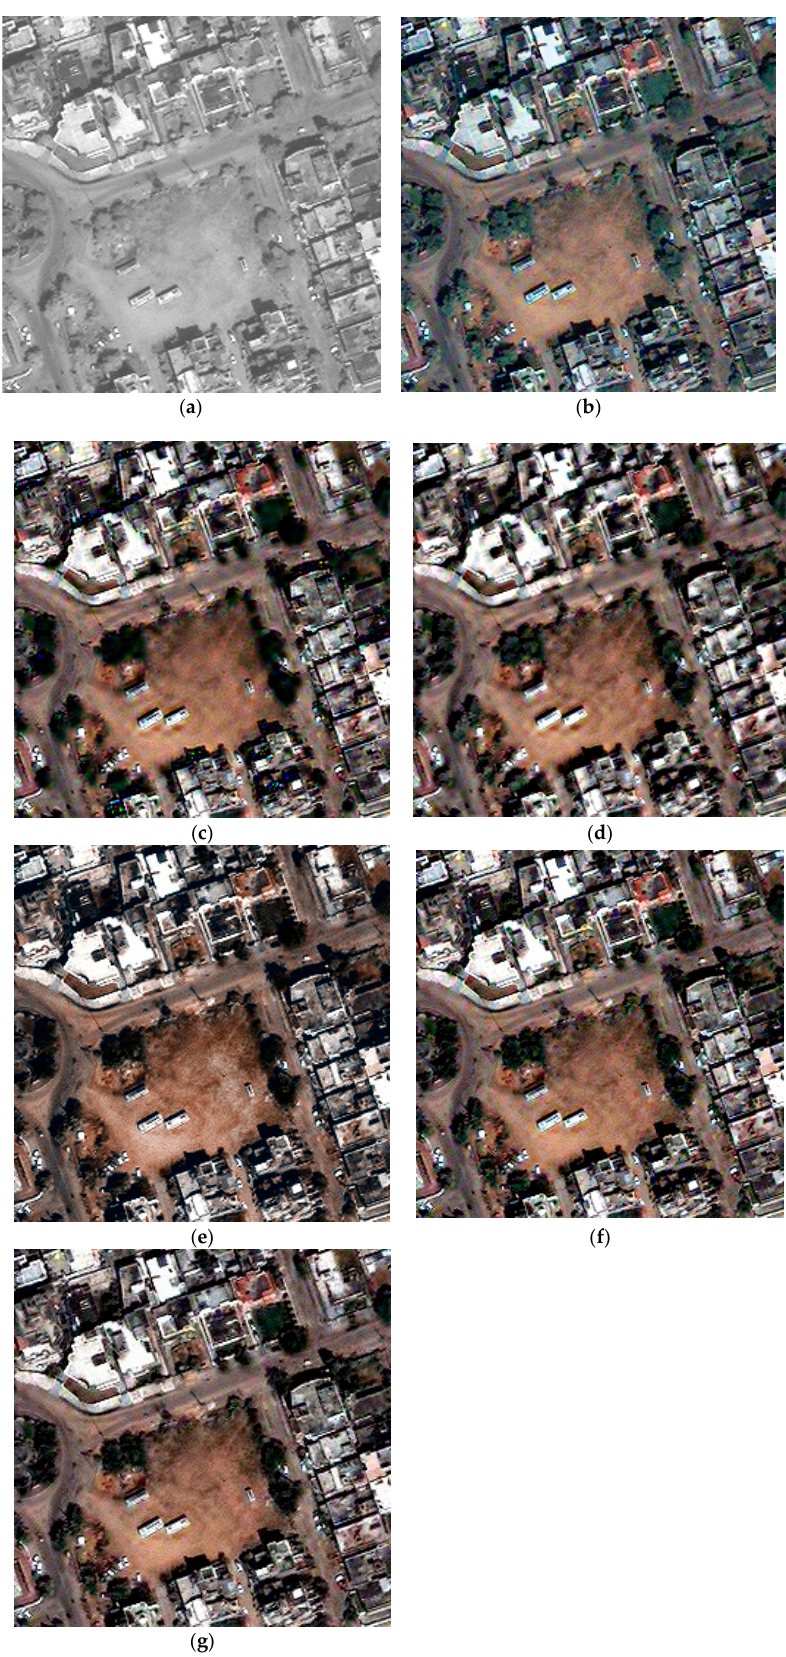
Figure 8. Real-data results for the Quickbird dataset. ( a ) Original PAN; ( b ) PCA; ( c ) SFIM; ( d ) MTF-GLP; ( e ) PNN; ( f ) DiCNN; ( g ) proposed.